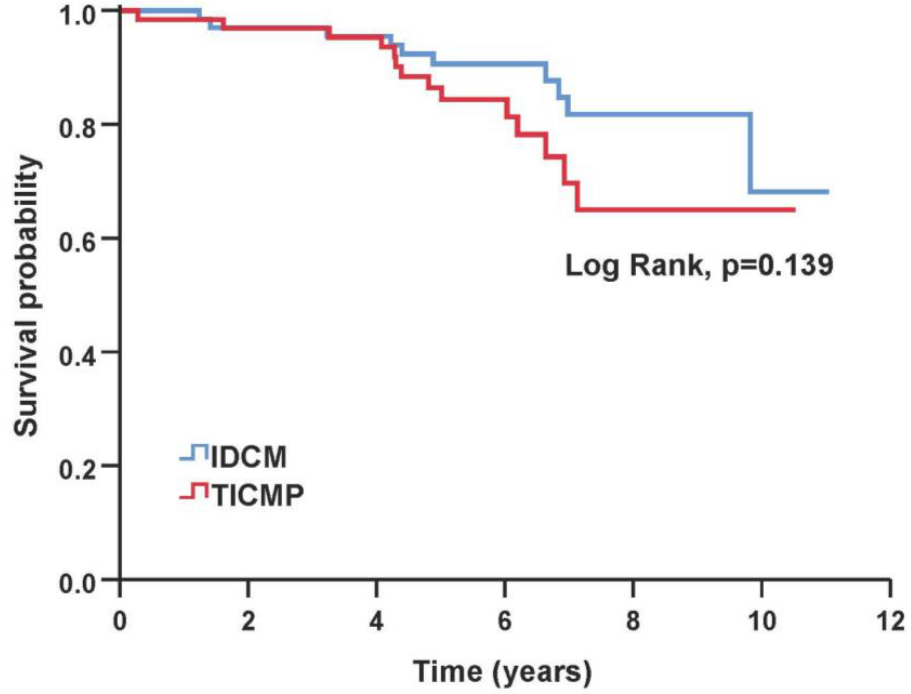
Figure 3. Kaplan–Meier estimates of overall survival based on the type of cardiomyopathy. IDCM— idiopathic dilated cardiomyopathy; TICMP—tachycardia-induced cardiomyopathy.